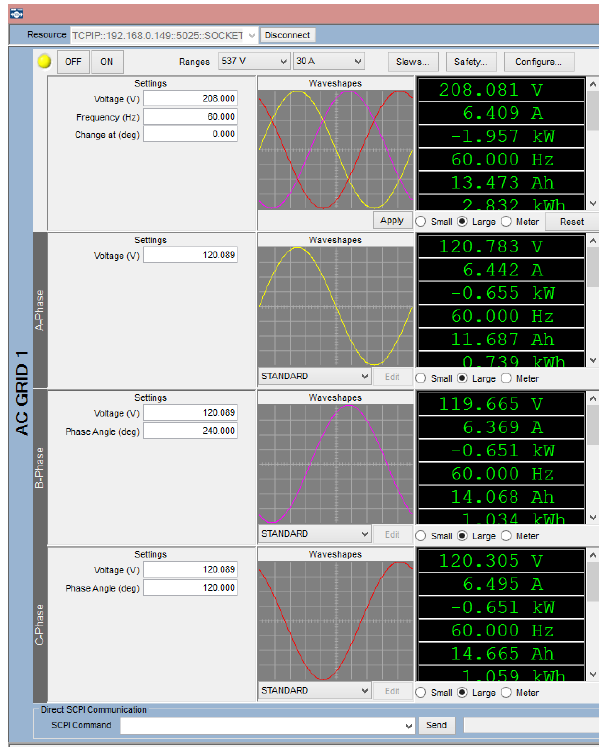
Figure 28. Hardware results using grid simulator NHR 9400 panel for real power = 2 kW and reactive power = var under unbalanced grid inductances.